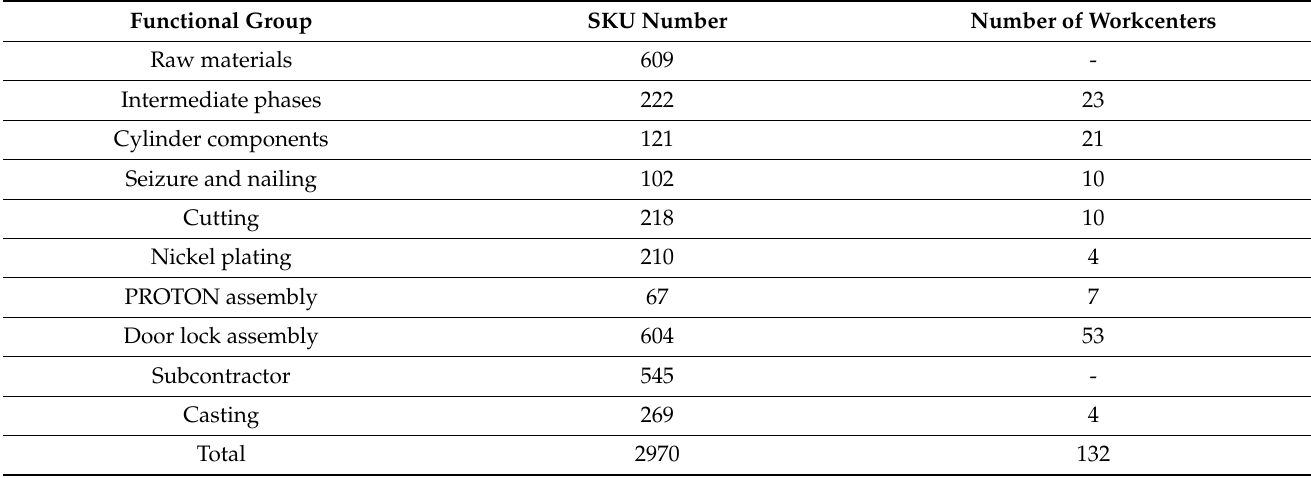
Table 2. Number of SKUs and work centers per functional